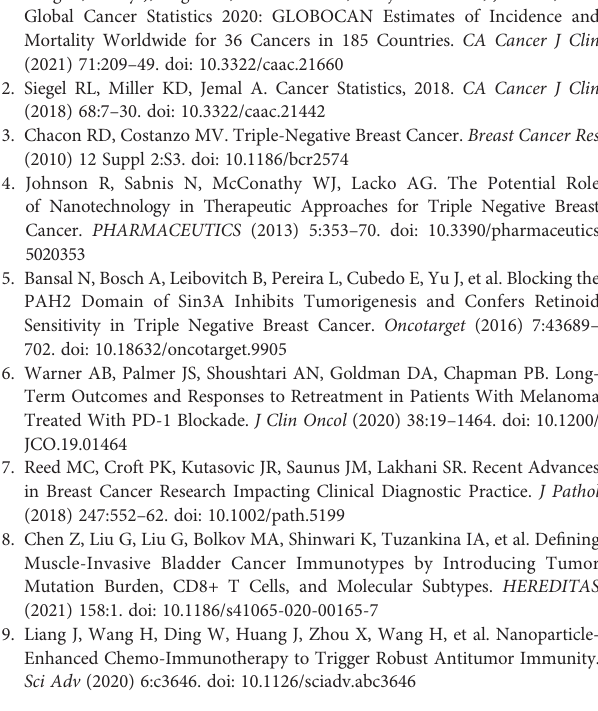
Supplementary Figure 1 | The selection of best value for the number of immune subtypes. (A) Tracking plot for k=2 to 6. In the Tracking plot, the colors in each row represented the samples in different subtypes. (B) Consensus clustering cumulative distribution function (CDF) for k=2 to 6. ( c ) Delta area curveof consensus clustering, indicating the relative change in area under CDF curve for each category number k compared with k − 1. The horizontal axis represents the category number k, and the vertical axis represents the relative change in area under the CDF curve. CDF, Consensus clustering cumulative distribution function. Supplementary Figure 2 | The correlation of the immune subtype with prognosis and TMB. (A) Five-year Kaplan – Meier curves for PFS of TNBC patients strati fi ed by the immune subtypes. p valuewas calculated bythe log-ranktest among subtypes.